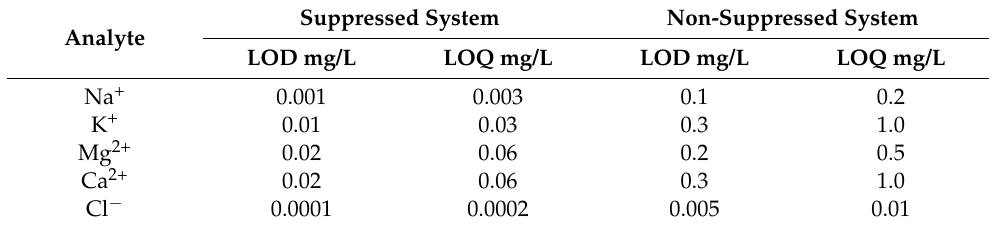
Table 4. LOD and LOQ of Na + , K + , Mg 2+ , Ca 2+ and Cl − obtained with the suppressed and non- suppressed